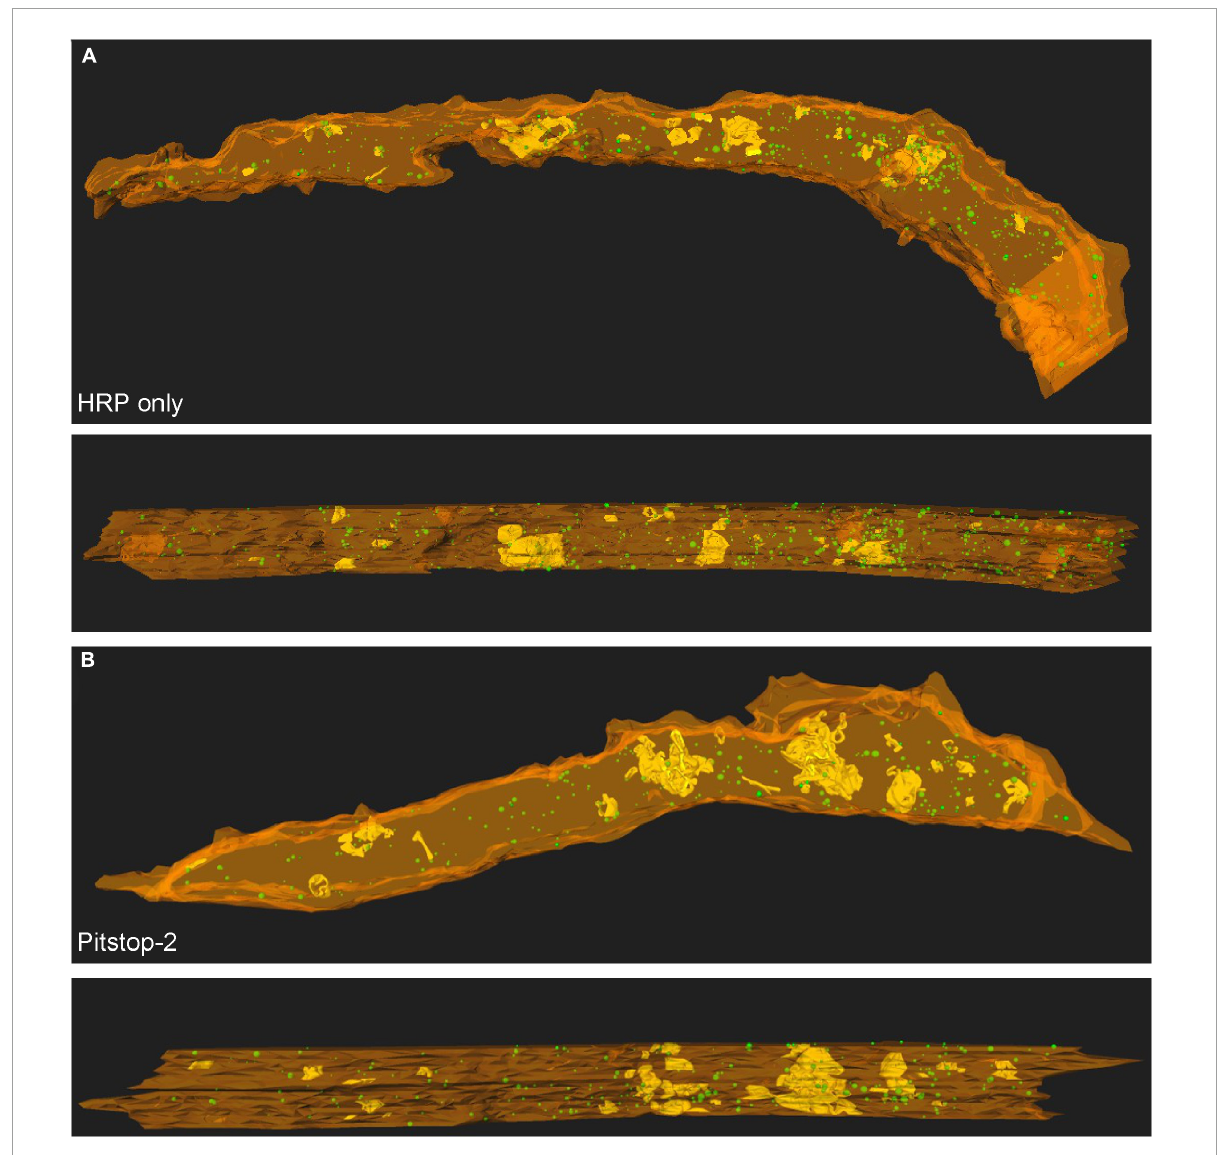
FIGURE2 Large endosomes and recently recycled bSVs are located throughout the calyx volume, irrespecitve of the presence or absence of Pitstop-2. (A) 3D reconstructions of endocytic compartments in a calyx of Held segment at P12/13 in the absence of Pitstop-2 (HRP only control). (B) 3D reconstructions of endocytic compartments in a calyx of Held segment at P12/13 in the presence of Pitstop-2. PM appears in orange, large endosomes are depicted in yellow and bSVs as green spheres. The innervation side is facing the bottom (top) or the front (bottom).